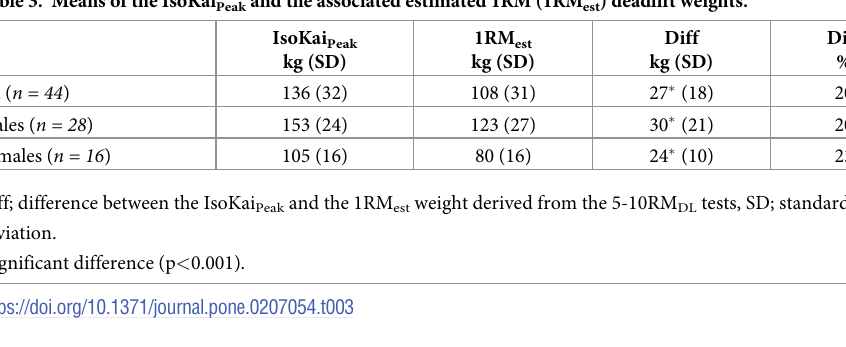
Table 4. Final linear regression estimates from the multivariable analysis for converting the IsoKai Peak (N) to an estimated 1RM (1RM est ) deadlift weight (kg), n = 44 . 1RM est (kg) β SE 95% CI B Intercept -51.63 24.32 IsoKai Peak (N) 0.08 0.01 0.06–0.09 0.76 BMI (kg/m 2 ) 2.28 1.04 0.17–4.39 0.19 β ; beta-coefficient, SE; standard error, 95% CI; 95% confidence intervals, B; standardised beta-coefficient.